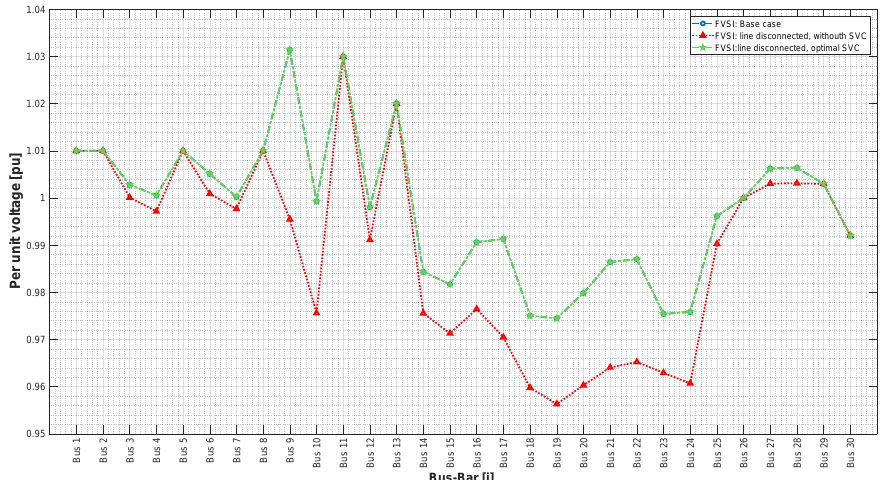
Figure 14. Second study case: Voltage profiles before/after contingencies and with SVC compensation, when the weakest line is